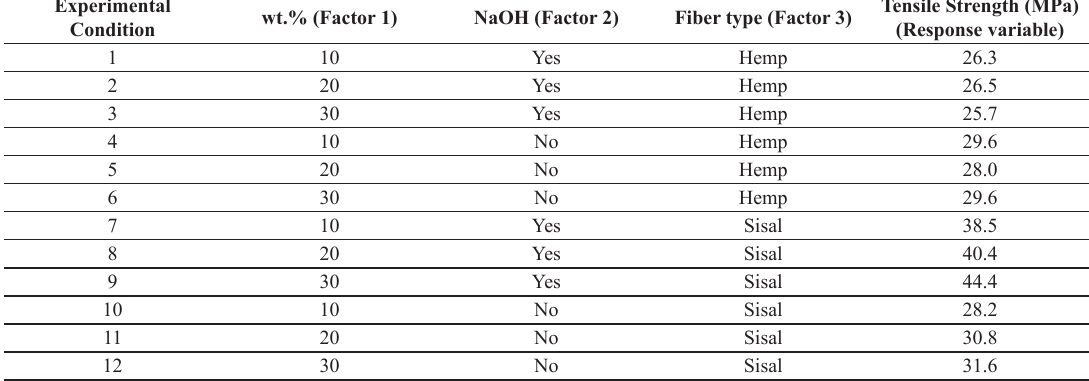
Table 3. Full factorial